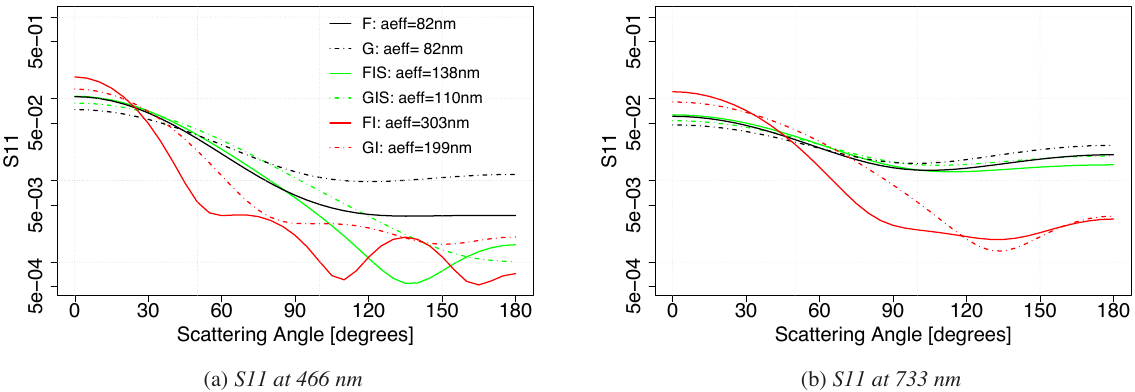
Fig. 8. Scattering phase function at 466nm (a) and 733nm (b) . Characteristics of the bare BC (cases F and G) and mixed BC-NaCl (cases FI, GI, FIS, and GIS) are described in Table 2 and Figs. 5, and 6. A scattering angle of 0 degrees corresponds to radiation that is scattered in the forward direction (i.e., in the same direction as the incident radiation). A scattering angle of 180 degrees is backscattering. The coated aggregates are departing from the Rayleigh regime, and therefore display some angular variation, with forward scattering increasing. common to the optical properties of dust and organics (Rus- sell et al.,